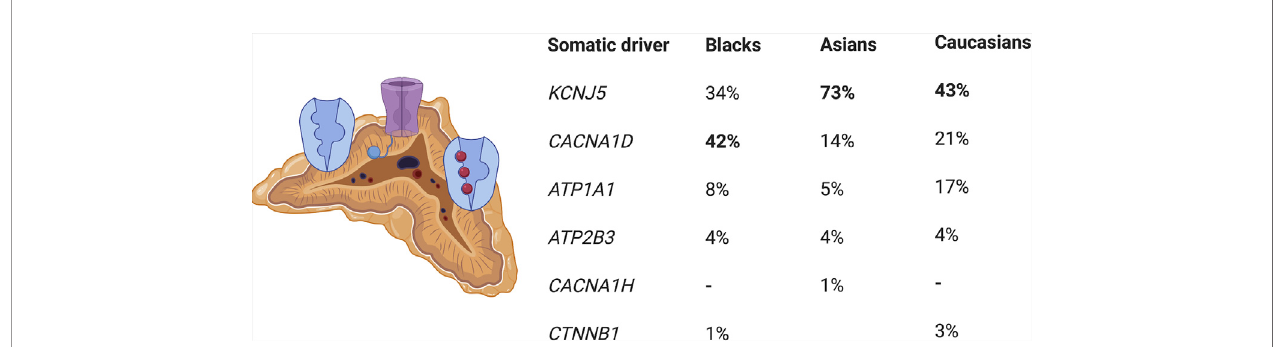
FIGURE 1 | Prevalence of somatic driver pathogenic variants in aldosterone-producing adenomas. KCNJ5, potassium channel, inwardly rectifying, subfamily J, member 5; CACNA1D, calcium channel, voltage dependent, L-type, alpha-1D subunit; ATP1A1 ATPase, NA+/K+ transporting, alpha-1 polypeptide,; ATP2B3, ATPase, Ca(2+)-transporting, plasma membrane, 3; CACNA1H, calcium channel, voltage dependent, T-type, alpha-1H subunit; CTNNBI, catenin,